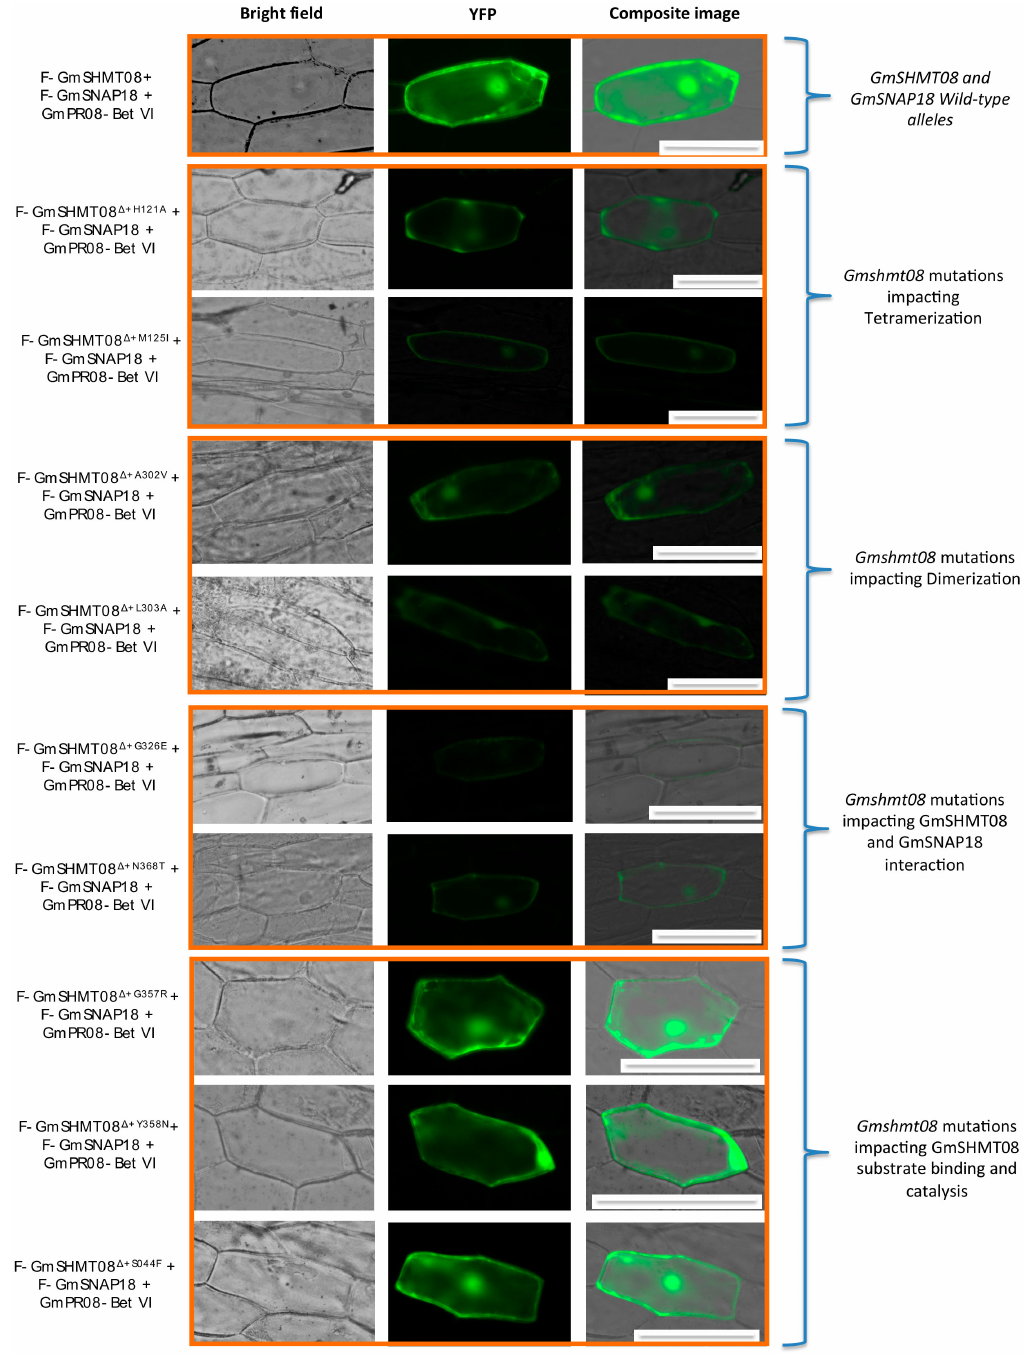
Figure 5. BiFC analysis between GmSNAP18, GmPR08, and the nine GmSHMT08 mutated alleles. The coding sequence of the 9 GmSHMT08 mutant alleles were cloned into pSAT4-nEYFP-C1 to generate nEYFP-GmSHMT08 mutant fusions. Likewise, GmSNAP18 from the Forrest WT and GmPR08-Bet VI were cloned into pSAT4-cEYFP-C1-B and pG2RNAi2 to generate cEYFP-GmSNAP18 and pG2RNAi2-GmPR08-Bet VI fusions. Various combinations of cEYFP and nEYFP control fusions were co-expressed in onion epidermal cells by particle bombardment (Figure S2). Bar = 200 µ M. Additionally, we tested, using BiFC, the five Gmsnap18 mutations ( Gmsnap18 Gmsnap18 ∆ + Y286D , Gmsnap18 ∆ + E287D , Gmsnap18 ∆ + V288* , and Gmsnap18 ∆ + I289L ) corresponding to